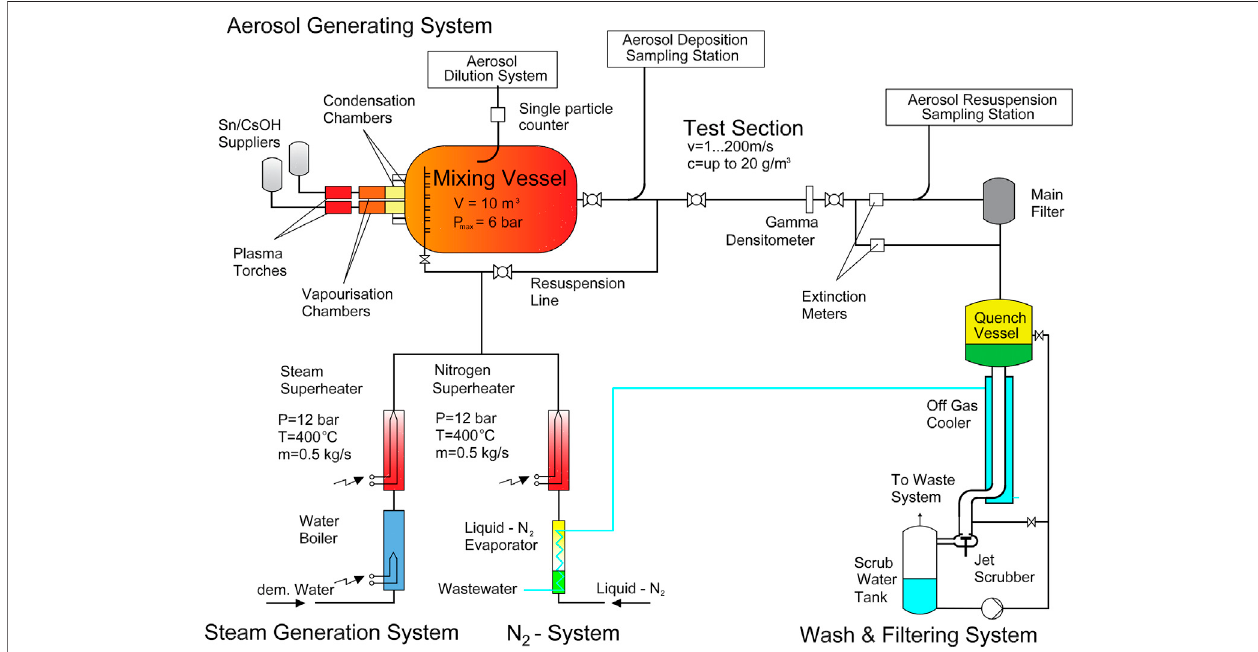
FIGURE 5 | STORM experimental facility (Castelo et al., 1999).